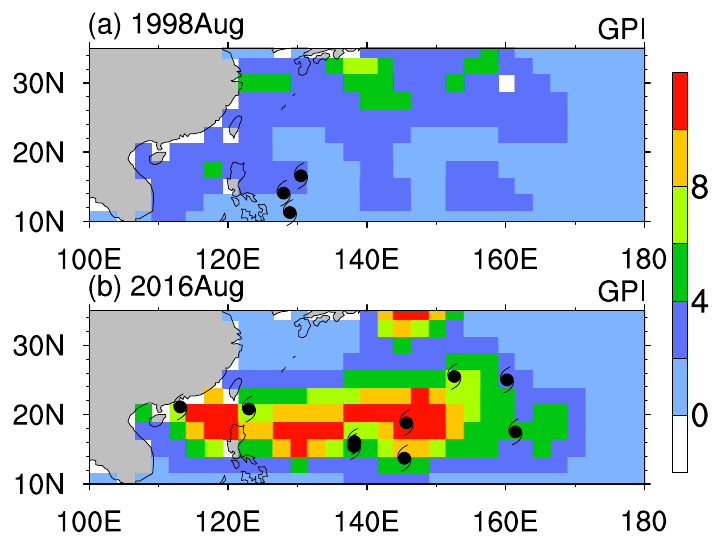
Figure 12. Spatial distribution of the genesis potential index (GPI) (shading) and the tropical cyclone (TC) geneses positions during August in ( a ) 1998 and ( b ) 2016.